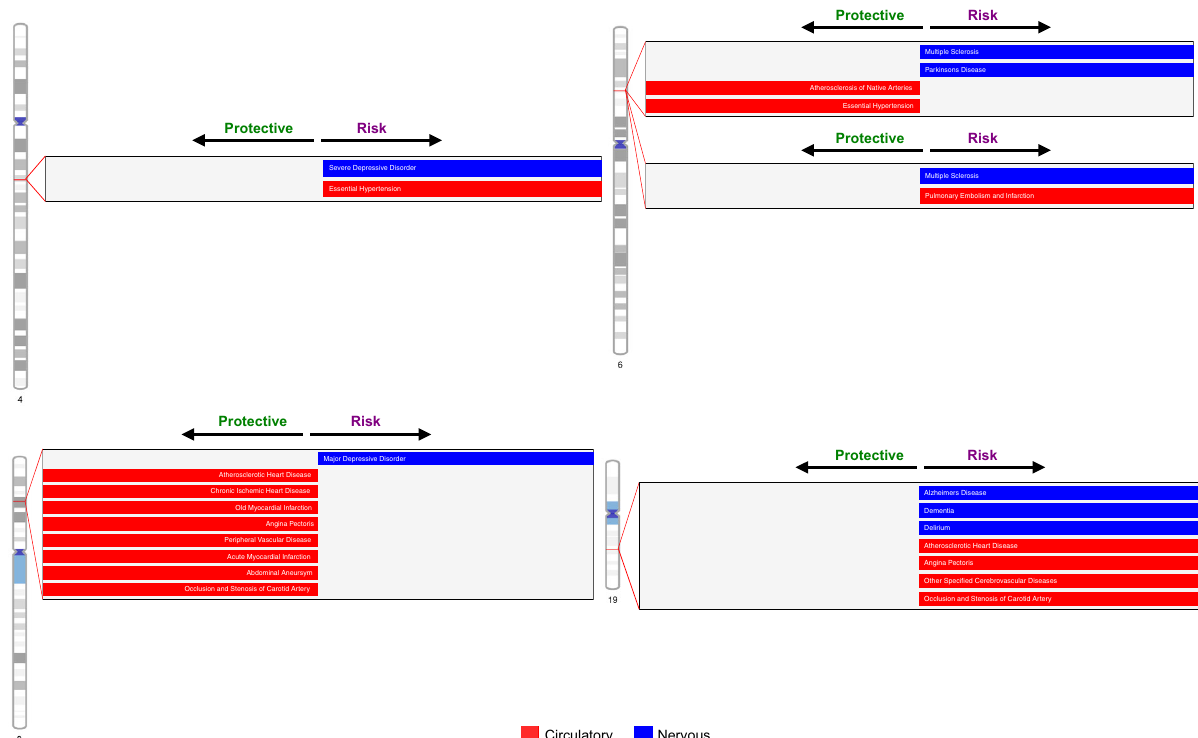
Fig. 3 Landscape of MultiPhen results. A position-to-position comparison of MultiPhen results between eMERGE and UKBB. The red line indicates a p - value of 1 × 10 − 8 . To reduce the margin induced by the extreme small p -values, we have collapsed SNPs with p -value < 1 × 10 − 75 into one overlapping circle indicated by an asterisk on chromosome 4 for UKBB.